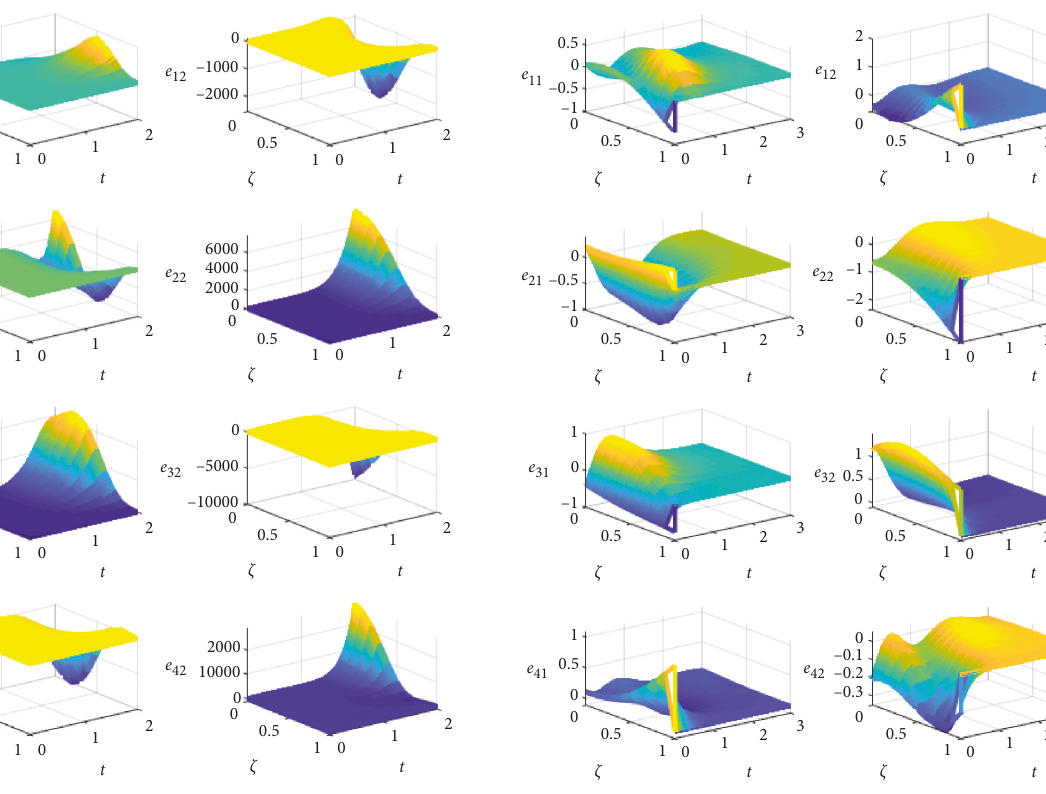
Figure 4: The open-loop profile of z